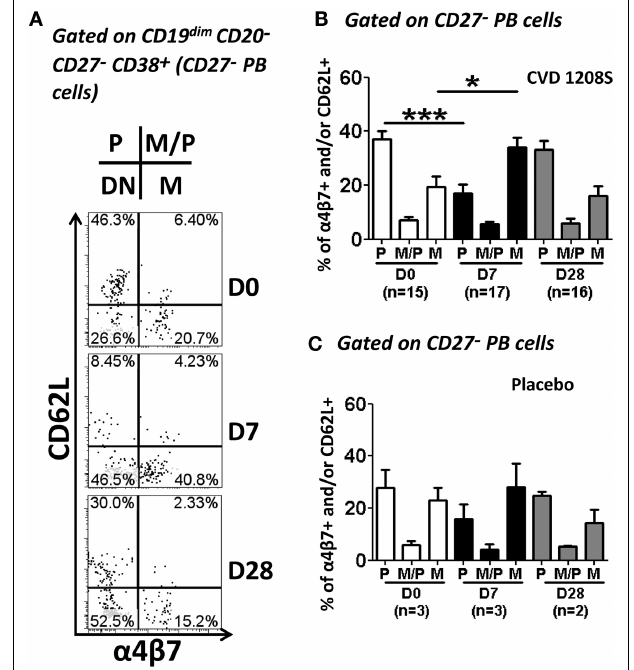
FIGURE 7 | Expression of homing molecules by CD27 − PB cells . CD27 − PB cells [CD19 dim CD20 − D27 − CD38 + (high) ] were gated as indicated in Figure 4 . Similar to CPB cells, CD27 − PB cells were evaluated for the expression of CD62L and integrin α 4 β 7 to determine their homing potential (A–C) . (A) Representative example of the increase in integrin α 4 β 7 and reduction of CD62L at day 7. (B,C) Compiled data of all vaccinated (B) and placebo (C) volunteers at each time point evaluated.White, black and gray bars indicate days 0, 7, and 28, respectively. Bars in plots indicate arithmetic mean ( ± SEM). Horizontal lines indicate groups compared and asterisk indicate statistical significance (* p < 0.05; *** p <